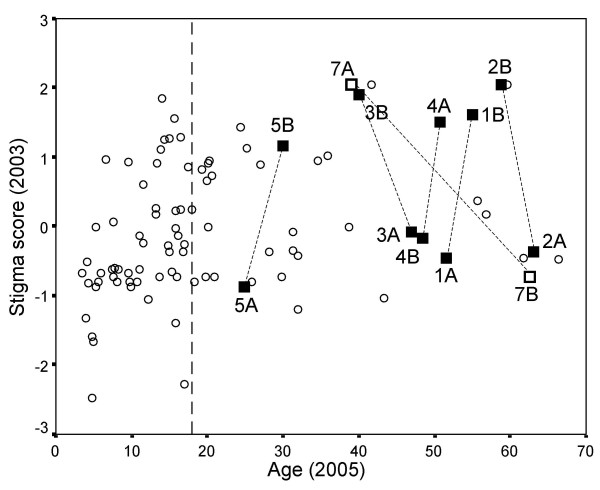
Questionnaire-based stigma scores in relation to age, for all participants in the 2003 questionnaire. Participants taking part in the current study are indicated by squares, with open squares for males and solid squares for females, and their pair membership shown.